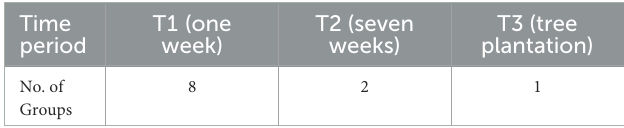
TABLE 3 Intergenerational and intragenerational contributions of experiment I.